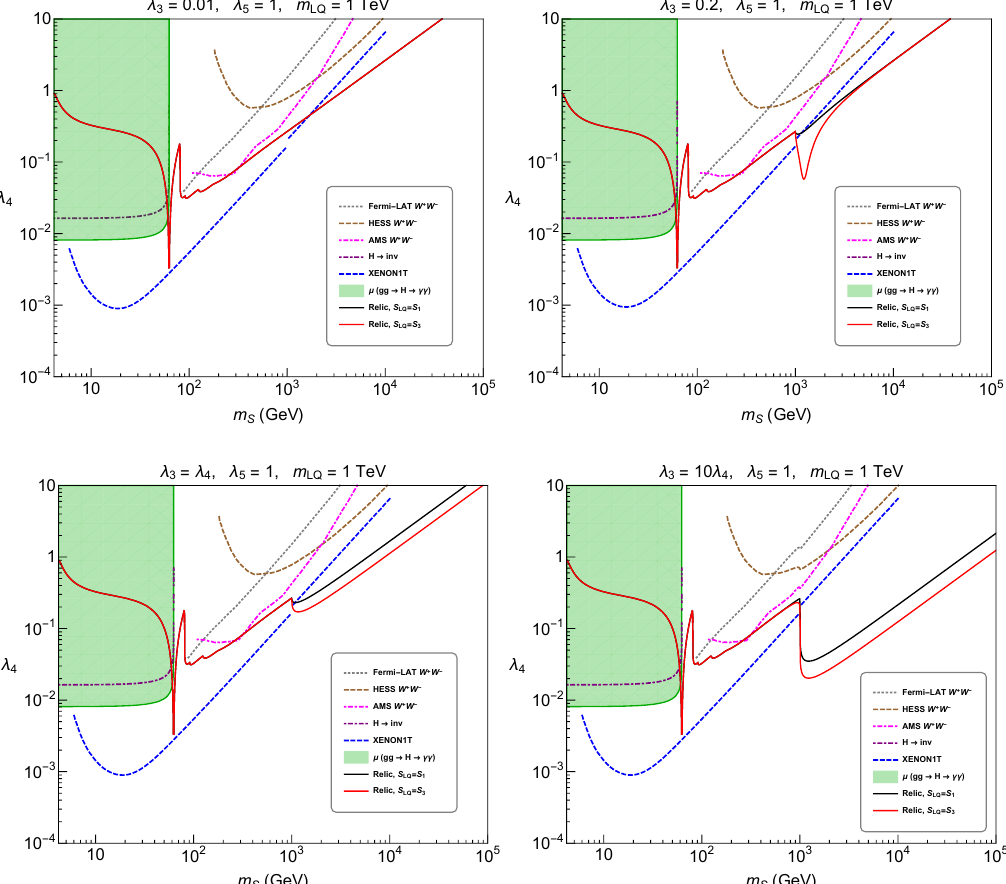
Figure 7 . Relic density for scalar dark matter and various bounds in the parameter space, (cid:21) 4 vs m S . The correct relic density can be obtained along the black and red solid lines, for models with singlet and triplet scalar leptoquarks, respectively. XENON1T bounds are shown in blue dashed lines. Indirect detection constraints from gamma-ray searches in Fermi-LAT (gray dotted) and HESS (brown dashed), and antiproton search in AMS-02 (pink dot-dashed) are overlaid. The bound from Higgs invisible decay is shown in purple dot-dashed line and the green regions are excluded by visible decays such as the Higgs diphoton signal